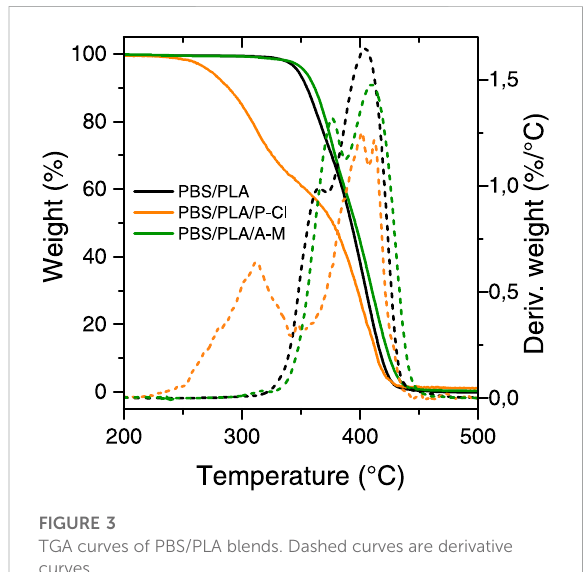
FIGURE 3 TGA curves of PBS/PLA blends. Dashed curves are derivative curves.